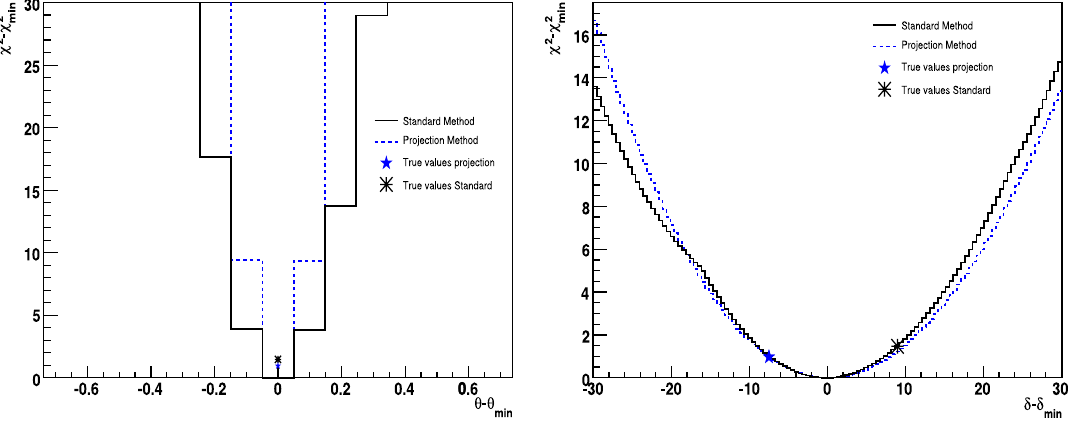
¼ 1 (cid:7) and (cid:2) ¼ 45 (cid:7) . 13